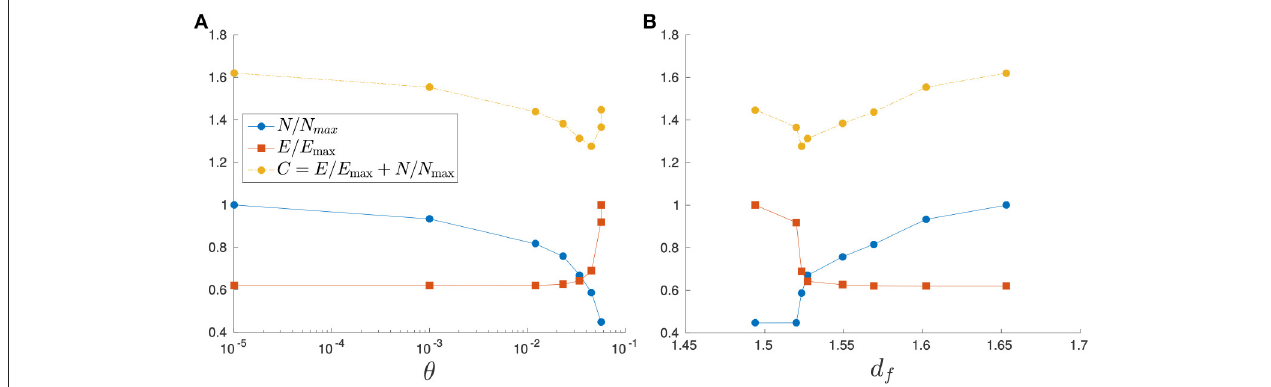
FIGURE 7 | Behaviors of the dissipated energy E , the number of nodes N and the function C of θ -subnetwork extracted from a percolation cluster of percolation probability p = 0.60. The curves are plotted with respect to θ (A) and d f (B) .